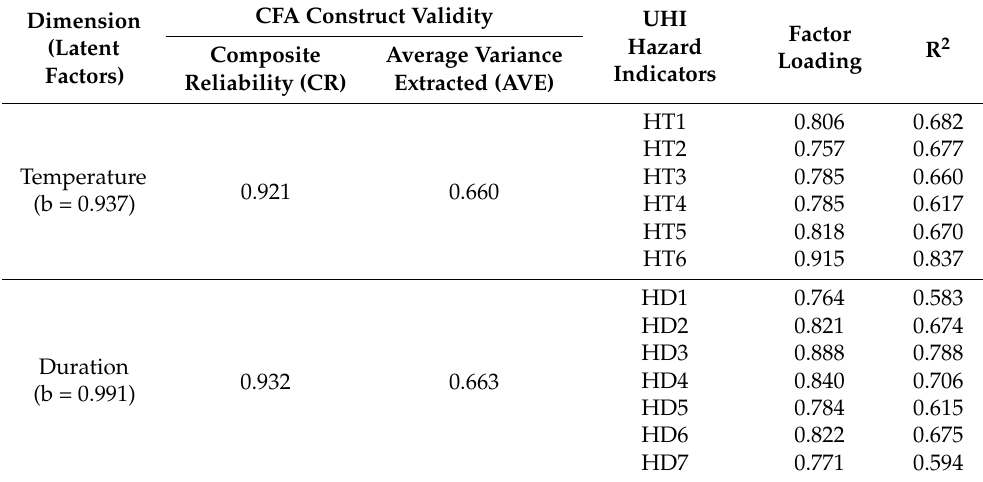
Table 5. First- and second-order CFA of UHI hazard indicators.